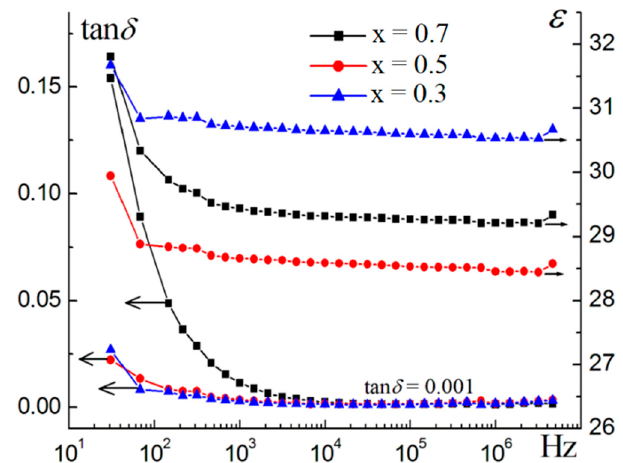
Figure 10. Dependence of the dielectric permeability and the dielectric loss tangent on frequency for the Bi 2 Mg x Fe 1-x Ta 2 O 9.5- Δ at 20 ° С .